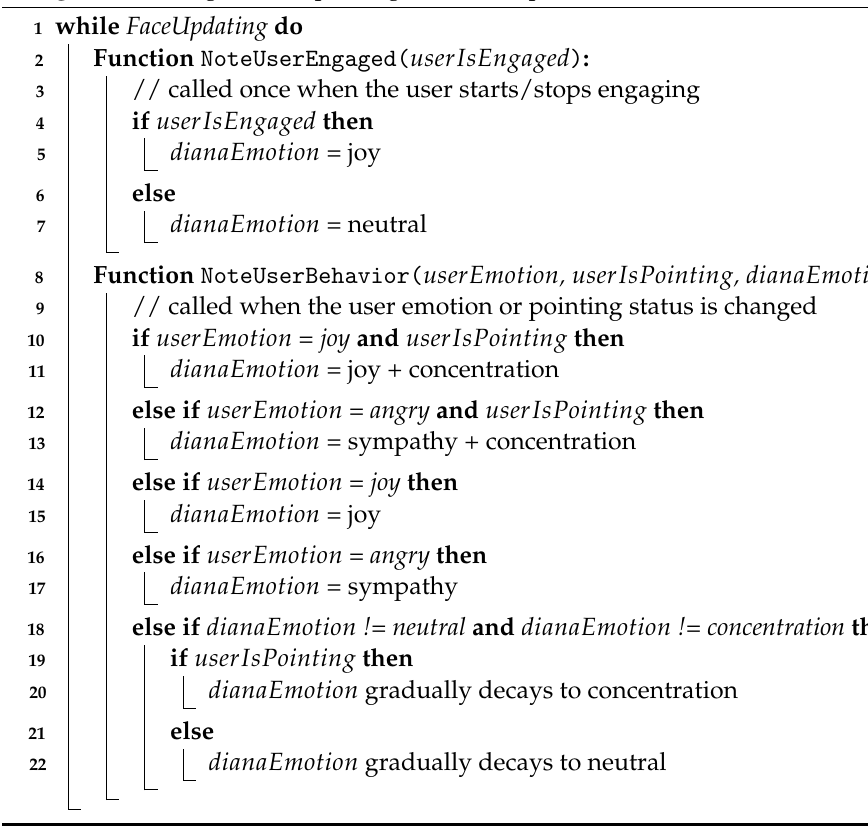
Algorithm 1: Algorithm updating Diana’s responsive affect